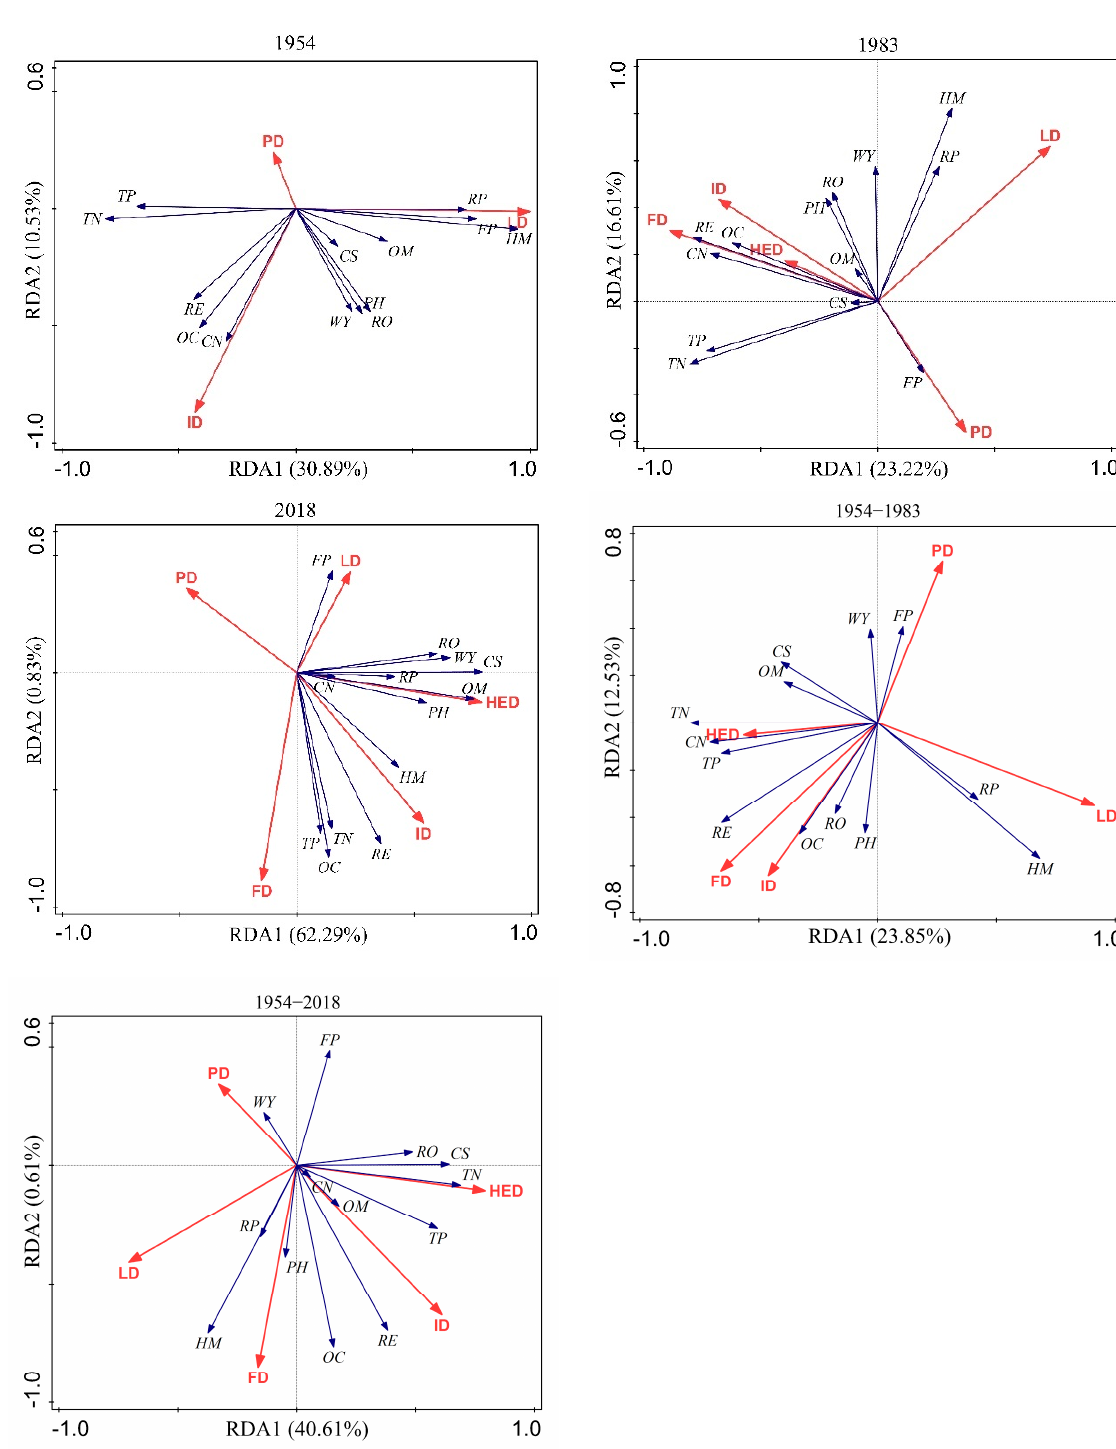
Table 2. Redundancy analysis in a different single year or the change of two-time steps (1954, 1983, 2018, 1954–1983, 1954–2018).